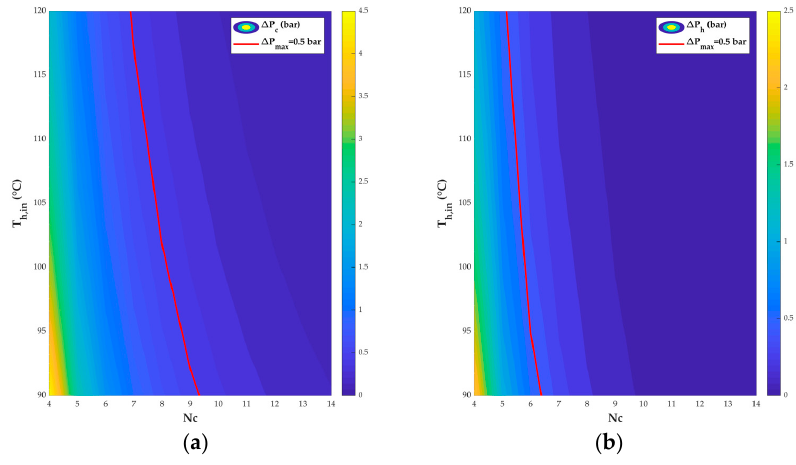
Figure 5. Pressure drops in cold ( a ) and hot fluid ( b ).